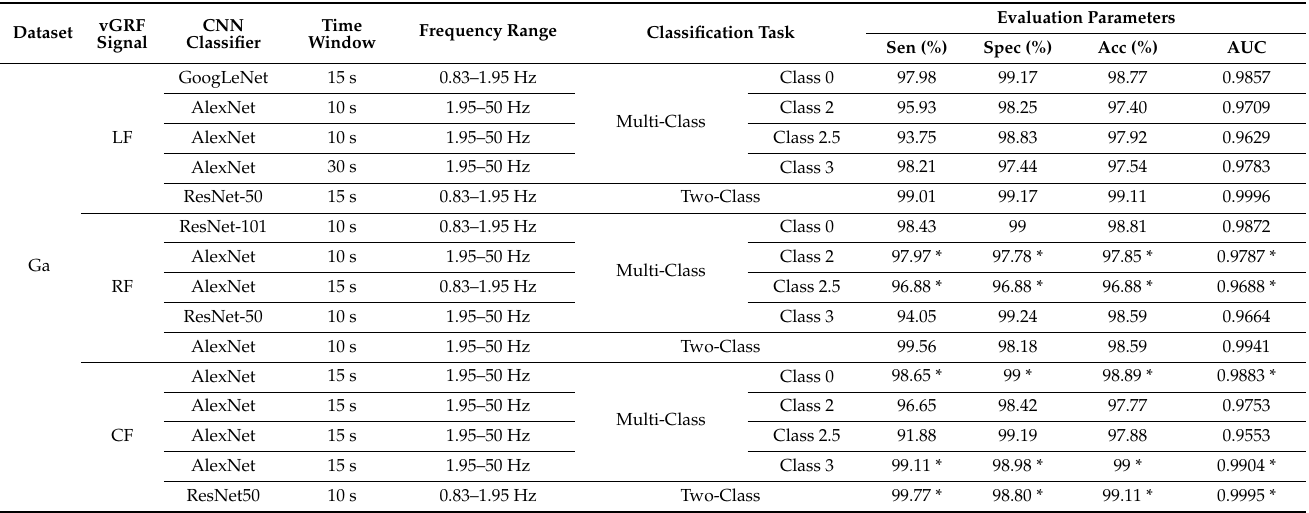
Table 20. Multi-class (CO (Class 0) vs. PD Stage 2 (Class 2) vs. PD Stage 2.5 (Class 2.5), and PD Stage 3 (Class 3)) and two-class classification (CO vs. PD (Class 2, Class 2.5, and Class 3)) summary using several CNN classifiers (AlexNet, ResNet-50, ResNet-101, and GoogLeNet) with 10-fold cross-validation for Ga dataset.